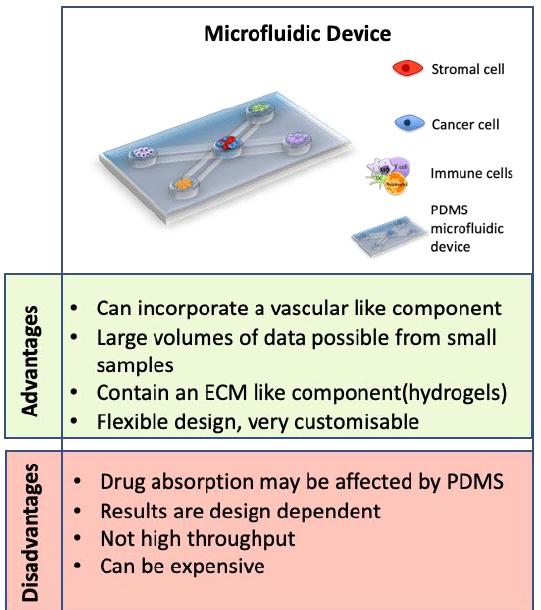
Figure 5. Advantages and disadvantages of microfluidic devices. A representative image of a microfluidic device is shown as well as a summary of the advantages and disadvantages of using a microfluidic device as a 3D model [154,156–158] .